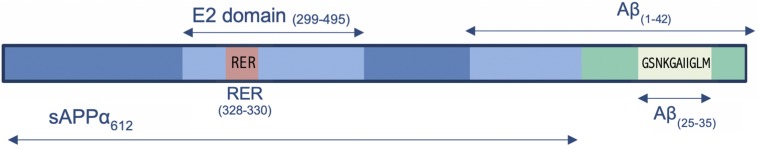
Schematic representation of the location of RER within the E2 domain of the sAPPα, while also showing the relative locations of Aβ(1–42), Aβ(25–35), sAPPα, and sAPPβ.